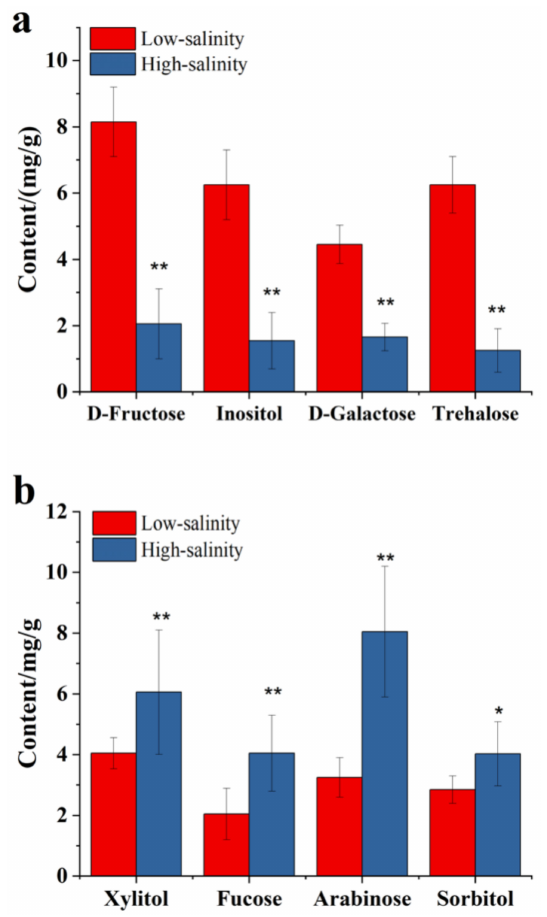
Figure 7. The quantitative contents of sugar metabolites in salt-treated purple sweetpotato. ( a ) The content of D-fructose, inositol, D-galactose and trehalose between low and high salinity. ( b ) The content of xylitol, fucose, arabinose and sorbitol in storage root of purple sweetpotato in low and high salinity treated. Columns represent mean values ( ± SD) of three biological replicates. Datasets with the same letter do not significantly differ (* p < 0.05, ** p <